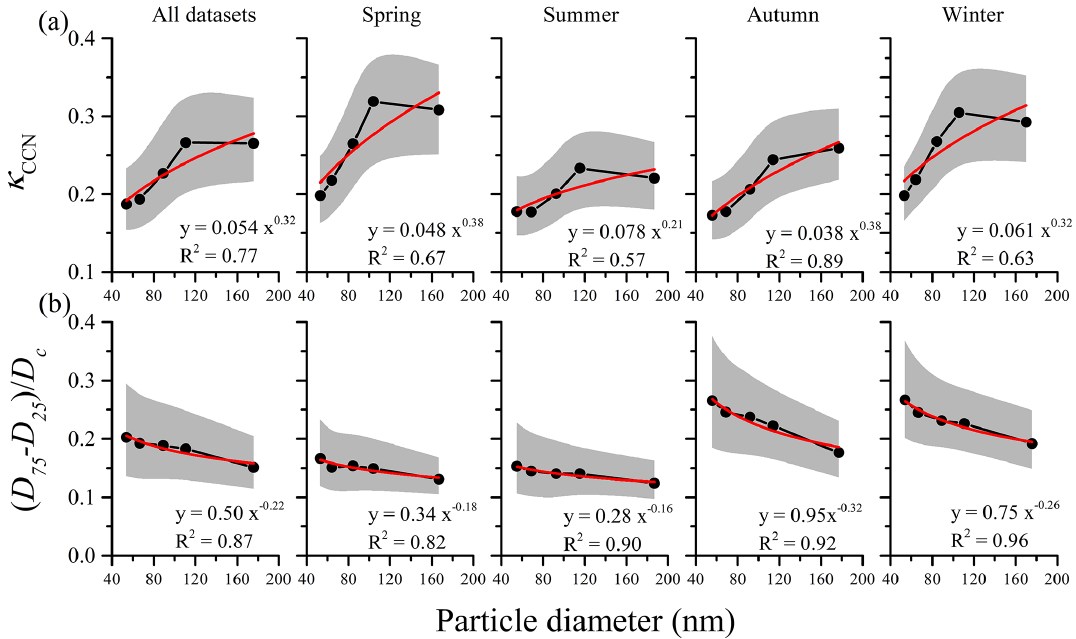
Figure 6. (a) Relationship between the hygroscopicity factor calculated from monodisperse CCN measurements ( κ CCN ) and particle diam- eter ( D p ), and (b) degree of external mixture (( D 75 − D 25 ) /D c ) vs. D p at each season. The definitions of D 75 and D 25 are the D p at which 75% and 25% of the particles are activated at the given SS, respectively. Red lines are power-law fits. Dots represent the median values. Shaded areas represent the values in the range from the 25th to 75th